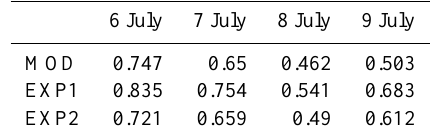
Table 3. Differences of averaged specific humidity at 2m above ground between the oasis and the desert (oasis minus desert) during the time period from 06:00 to 18:00BT for the MOD, EXP1 and EXP2 simulations (gkg − 1 ).